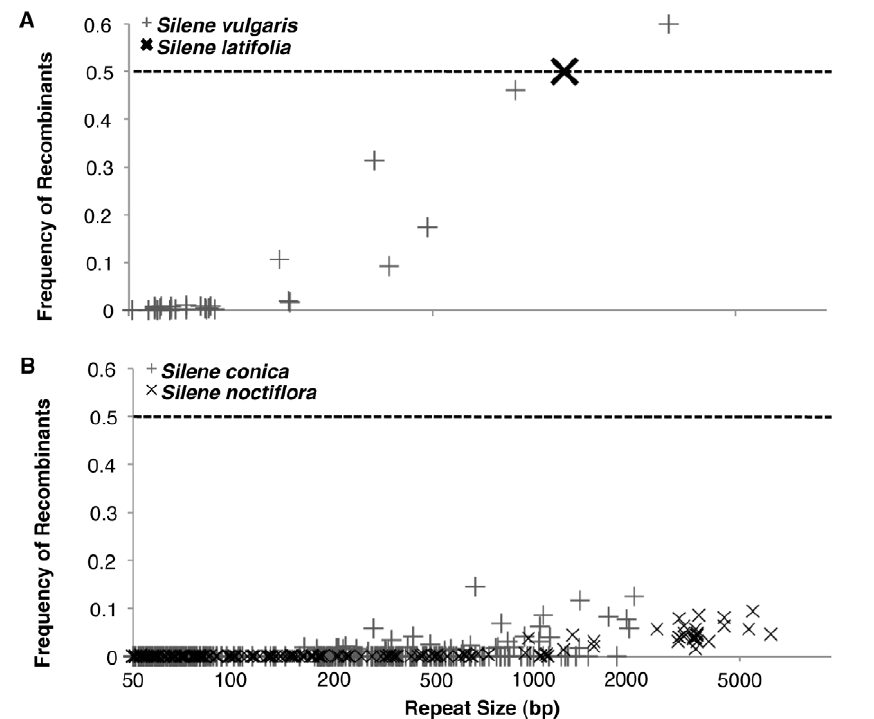
Figure 6. Repeat-mediated recombinational activity in the low mutation rate S.latifolia and S.vulgaris mitochondrial genomes (A) and the fast-evolving S.noctiflora and S.conica mitochondrial genomes (B). Each point represents a pair of repeats, and its position on the y - axis denotes the proportion of recombinant genome conformations detected with paired-end 454 reads. The dashed lines indicate the level at which equal frequencies of read pairs support recombinant and nonrecombinant conformations. The S. latifolia mitochondrial genome was not sequenced with 454 paired-end reads, but Southern blot hybridizations indicated that alternative genome conformations associated with its six-copy 1.4-kb repeat exist at roughly equivalent frequencies [38], as indicated by the large X.